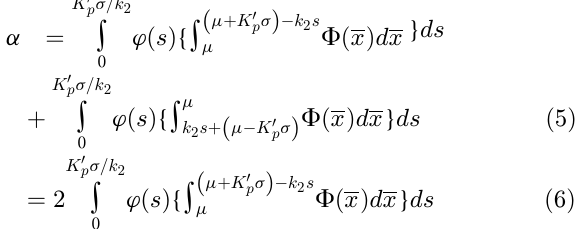
Table 1. Numerically determined factor k